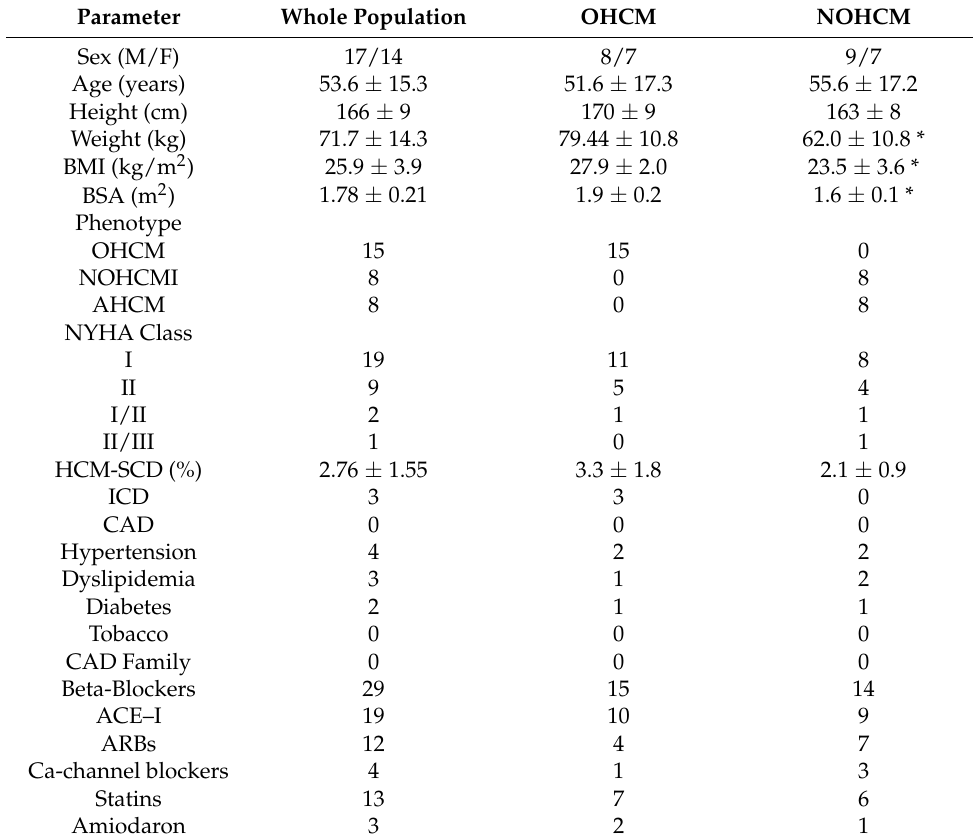
Table 1. Anthropometric and clinical data of the study population.